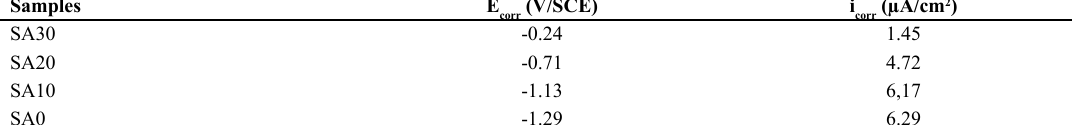
) values of the sanded sample and etched samples (10, 20 and 30 min) corr